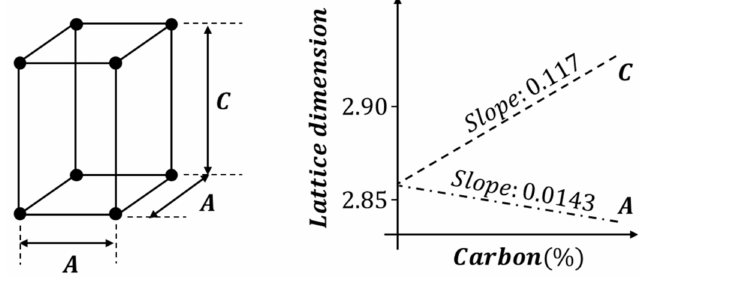
Figure 6. Lattice dimension by carbon ratio during martensite phase transformation.